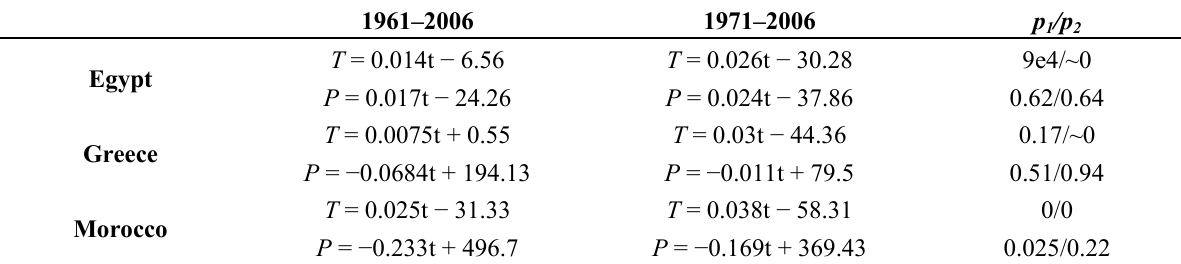
Table 1. Temperature and precipitation trends in the selected three countries, for the 1961–2006 and the 1971–2006 periods. T , P and t refer to temperature (°C), precipitation and p are the two-tailed t -test values for the (cm) and time (year), respectively. p 1 2 1961–2006 and the 1971–2006 periods, respectively. The relationship is statistically significant at the 95% confidence limit when p is lower than 0.05. While our study encompasses the period from 1961–2006 period, statistical analyses are given here as additional information for the 1971–2006 period also, where the trend in temperature change was more evident (see also Figure